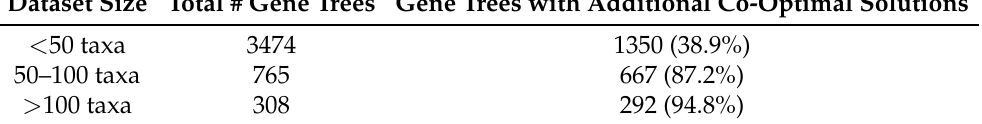
Table 6. Number of biological dataset gene trees that result in additional co-optimal reconciliations invoking TL and/or TX events. These results are based on event costs of 1, 2, 3, 4, and 4, for losses, duplications, transfers, TL , and TX ,